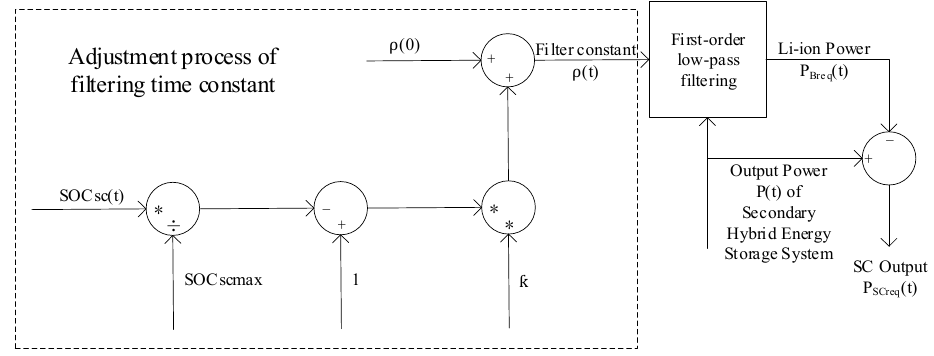
Figure 3. The working principle of the first-order variable filter constant low-pass filtering algorithm.